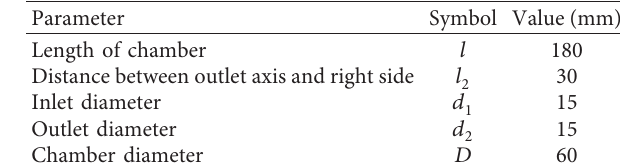
Table 1: The parameters of the side outlet